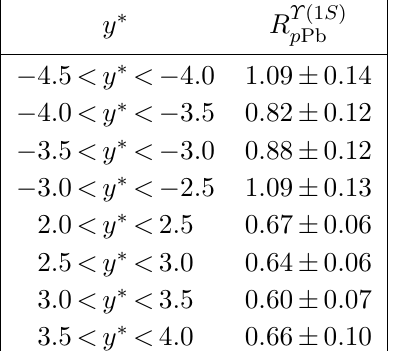
Table 13 . (cid:7) (1 S ) nuclear modi(cid:12)cation factor, R (cid:7) (1 S ) over p T in the range 0 < p T < 25 GeV =c